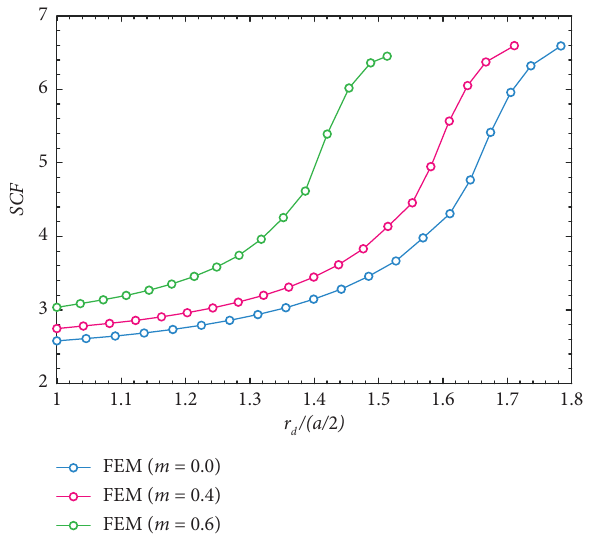
Figure 17: Evolution of the stress concentration factor at the breakout tip with the progression of the breakout.